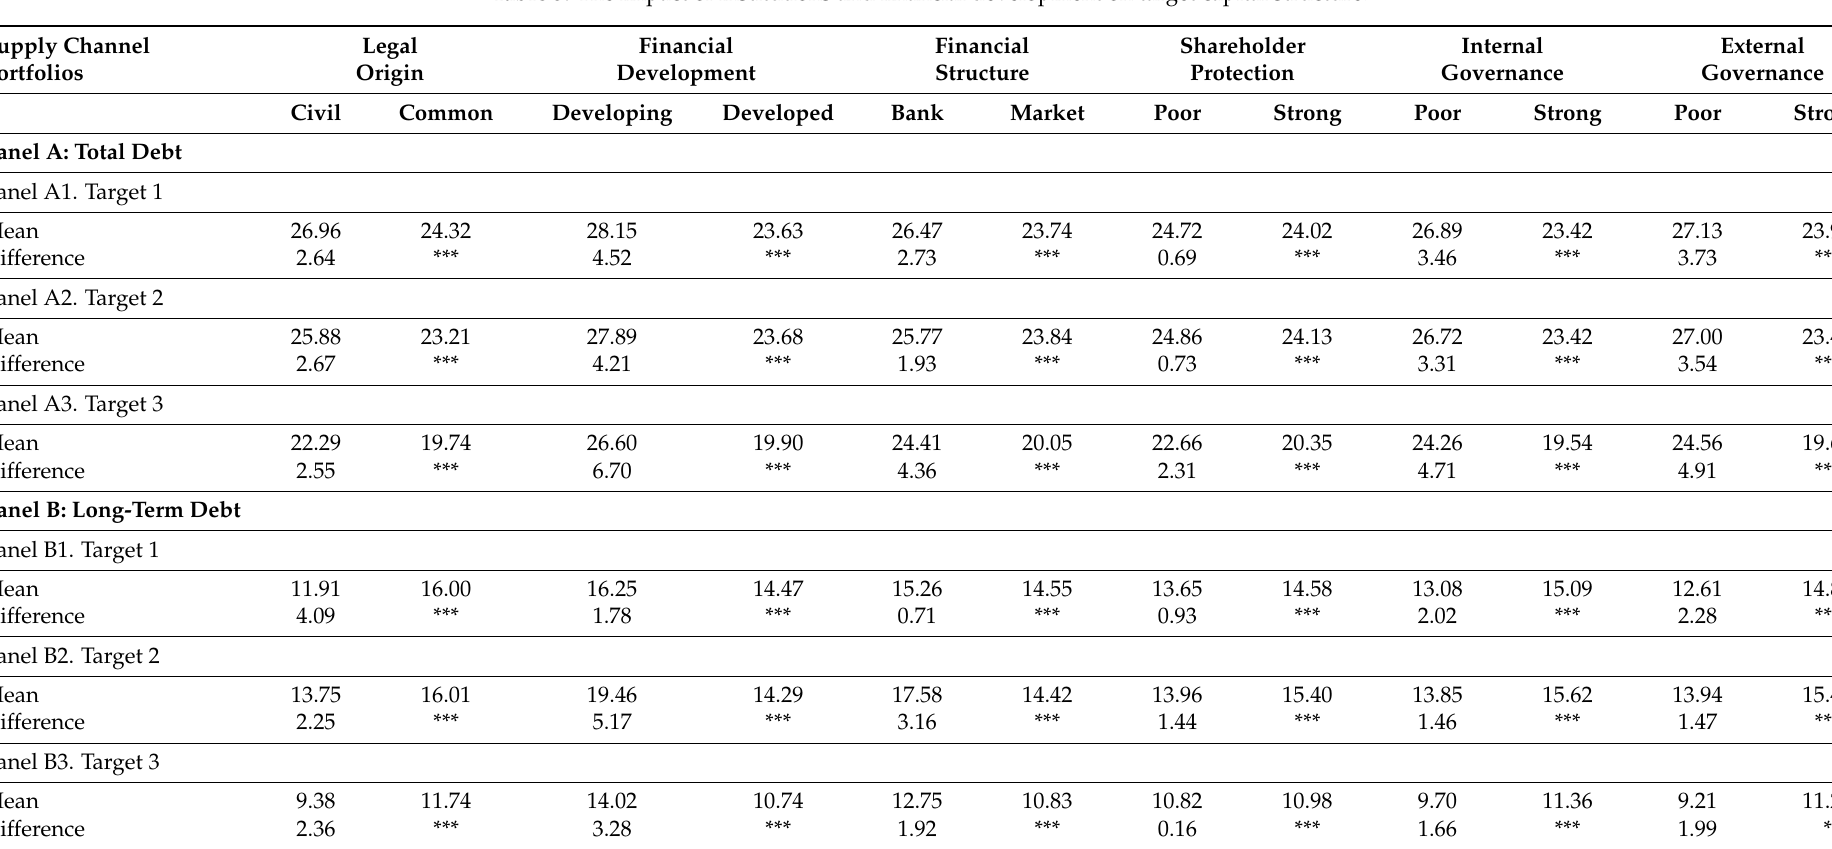
Table 5. The impact of institutions and financial development on target capital